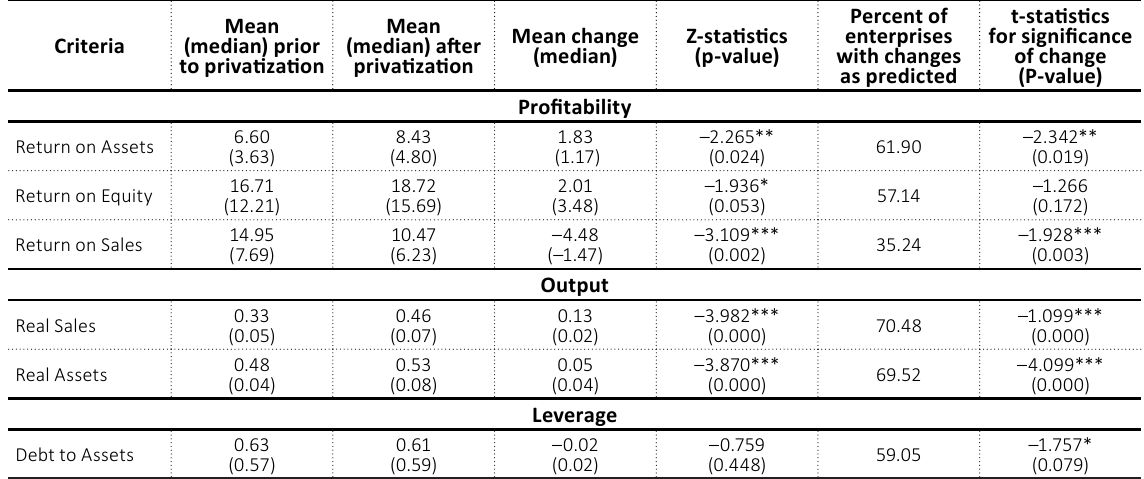
Table 3. Results of the Wilcoxon Signed Rank test for research firms’ financial performance